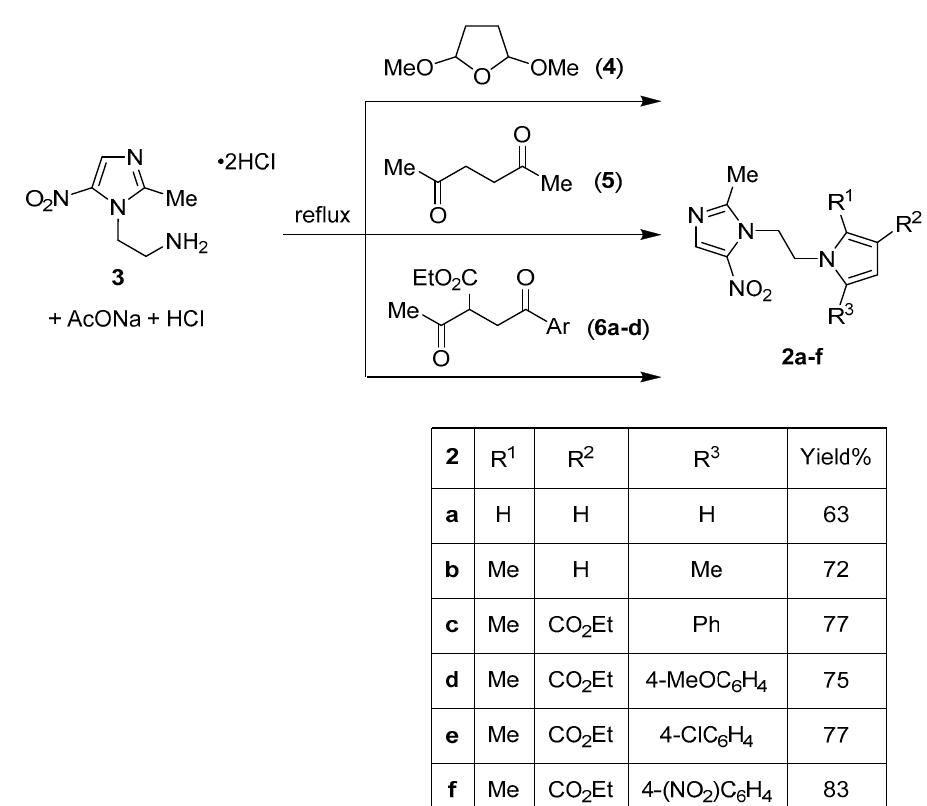
Scheme 1. Synthesis of 5-nitroimidazole / pyrrole hybrids 2a – f .